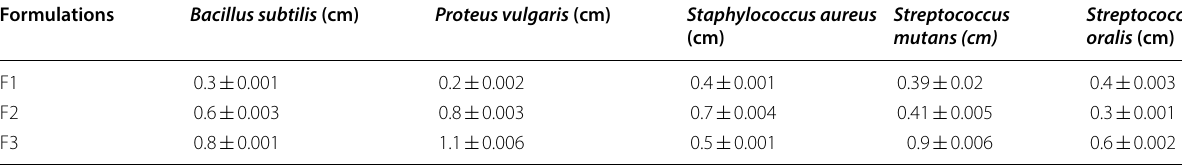
Table 4 Anti-microbial activity of tooth paste formulations